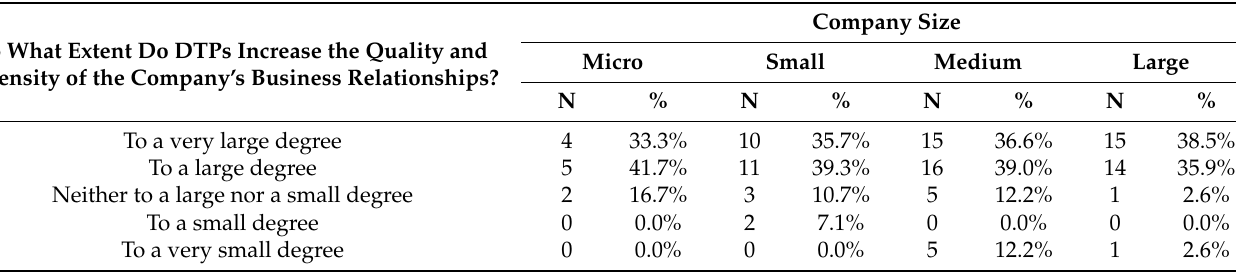
Table 6. The company’s relationships with the environment compared to the company size.